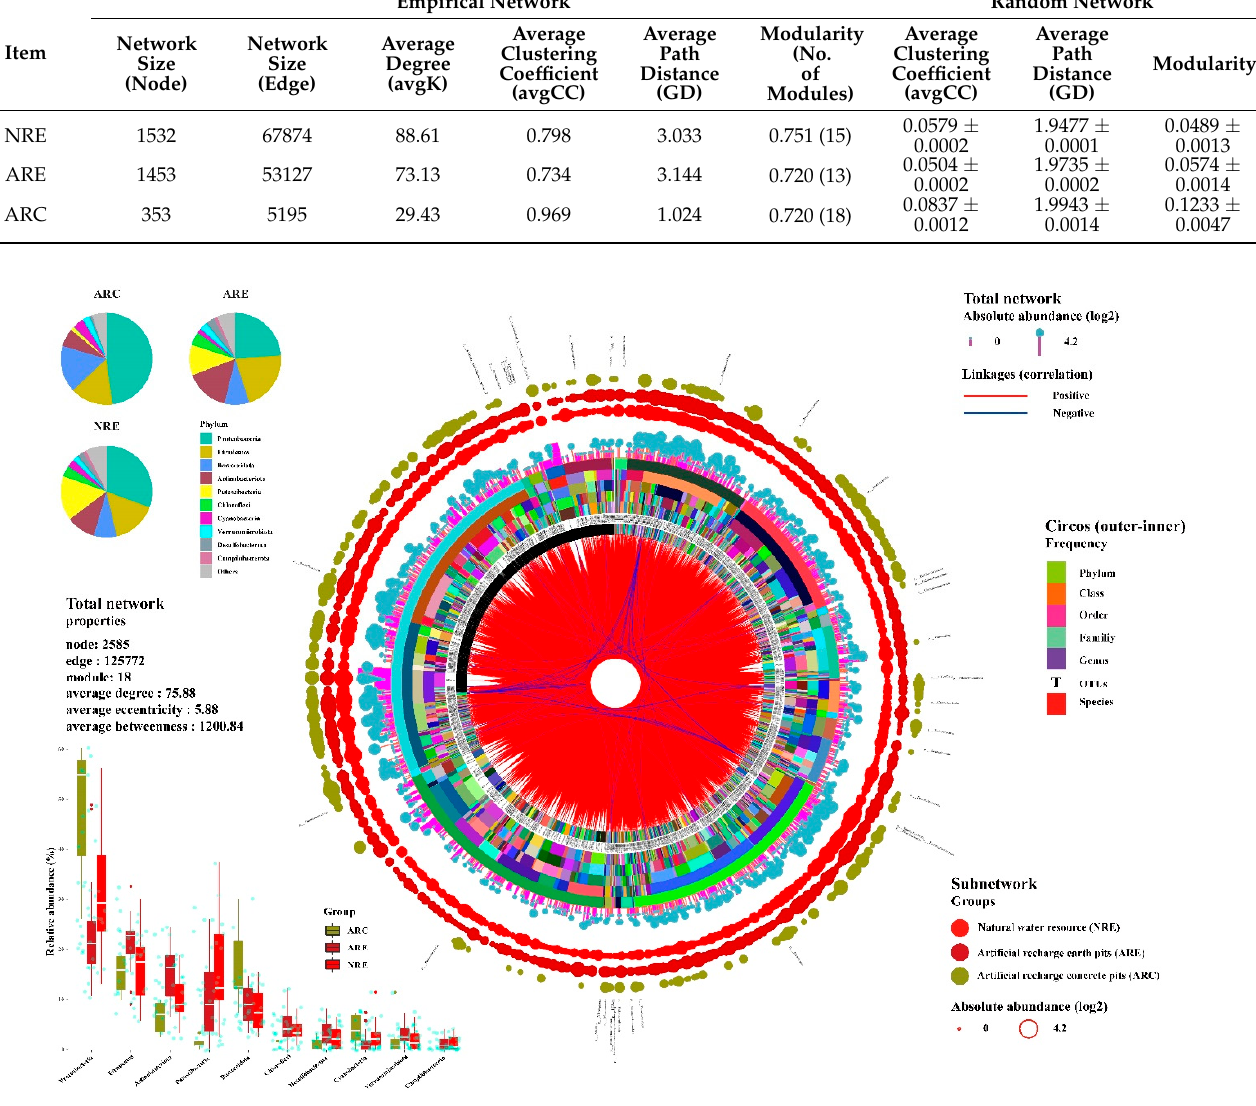
Figure 3. Circos diagram of total microbial co-occurrence network. Circos diagram consists of three parts: an outer layer of circles and dots, a middle layer of color blocks, and an inner layer of connecting lines. The outer layer was visualized by taking the logarithm of the microbial abundance of the total network; the middle layer presents the composition of microorganisms, with six layers from the outermost phylum level to the inner species level; and the innermost layer presents the interaction links between microbes, with positive correlations indicated with red lines and negative correlations indicated with blue lines.